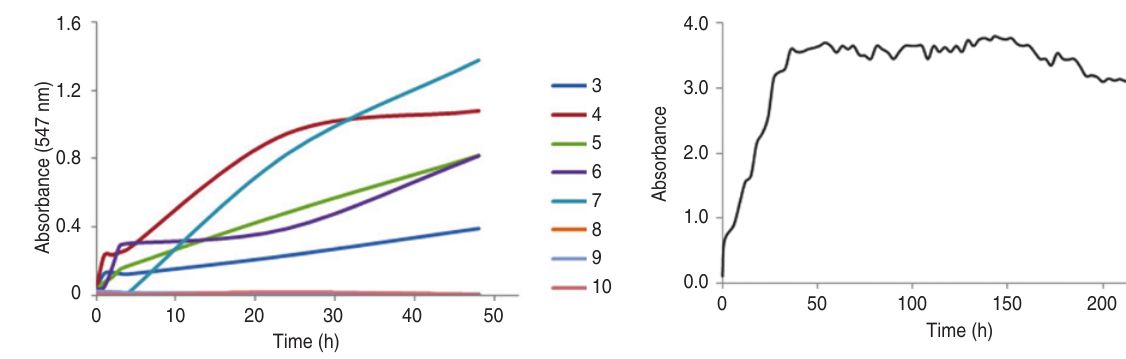
Figure 5: UV-Vis spectra of gold nanoparticles as function of time at room temperature and pH 7.